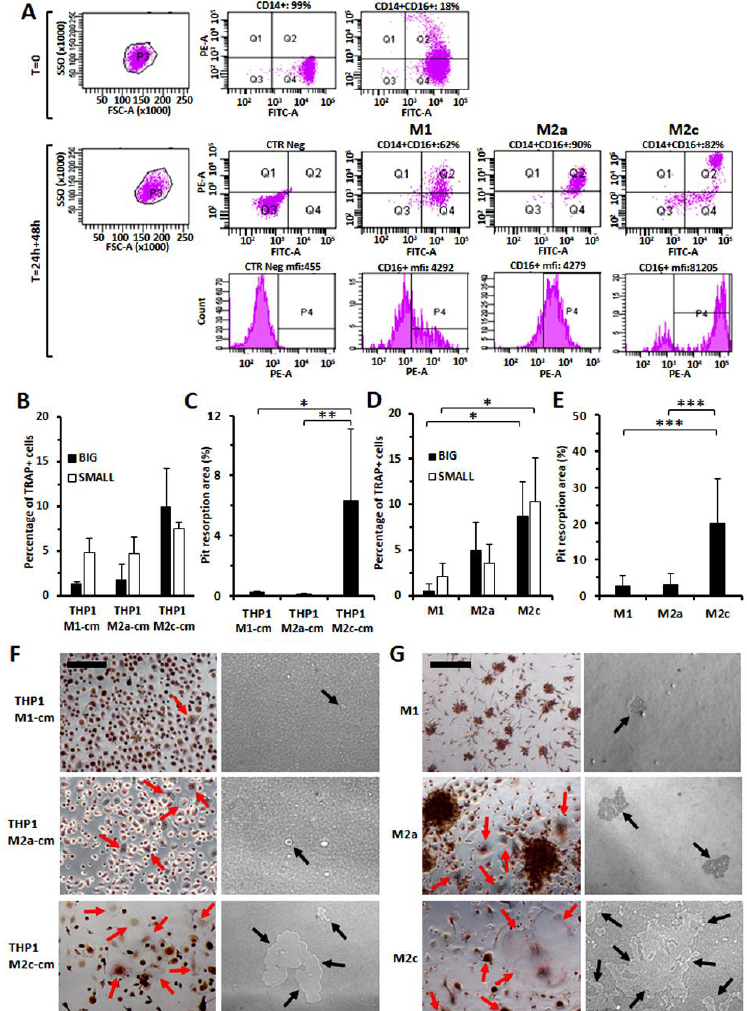
Figure 10. Assessment of CD16 up-regulation in monocytes purified from healthy donors polarized toward M1, M2a and M2c and determination of MCSF + RANKL-osteoclastic differentiation of mono- cytes pre-treated with culture medium from M1-, M2a-, M2c-polarized THP1 cells or of monocytes directly pre-polarized toward the three subtypes. ( A ) Dot plots show the increased percentage of CD16+ cells when monocytes were polarized toward M2. A very strong CD16 up-regulation was in particular observed in M2c-polarized monocytes (CD16 mfi = 81,205). ( B ) Healthy monocytes pre- treated with culture medium from M2c-THP-1 cells produced a higher number of frank osteoclasts (TRAP+, at least tri-nucleated, of big and small size). Histograms represent means ± SD of two sep- arate experiments using monocytes purified from two different healthy donors. ( C ) Larger pit re- sorption areas were also detected when healthy monocytes were pre-treated with THP1-M2c-con- ditioned medium (THP1-M2c-cm), in agreement with the higher number of frank osteoclasts de- rived. ( D ) M2-polarized monocytes gave rise to a higher number of osteoclasts (means ±SD of two separate experiments), and significant larger areas of erosion were visualized when osteoclasts were derived from M2c pre-polarized cells, as shown in ( E ). Statistical significance was determined by using ANOVA and Tukey’s post hoc test for ( C – F ). Osteoclasts originated only from THP1-M2 pre- polarized monocytes and show a larger size for THP1-M2c. ( G ) Images display cell morphological differences acquired after polarization toward M1, M2a and M2c phenotypes and the presence of classical osteoclasts only in M2 pre-polarized cells, showing, in particular, a larger size in M2c. Larger pit resorption areas were detected in M2c-derived osteoclasts. For all images in panels F and G correspond to 25 µm.